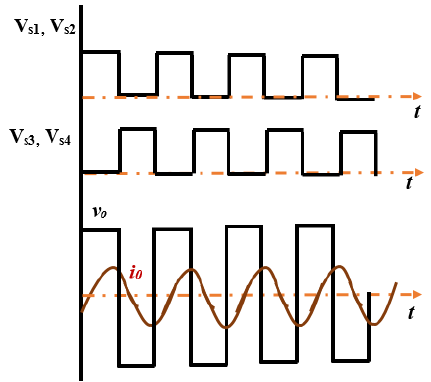
Figure 3. Typical voltage and current waveforms.